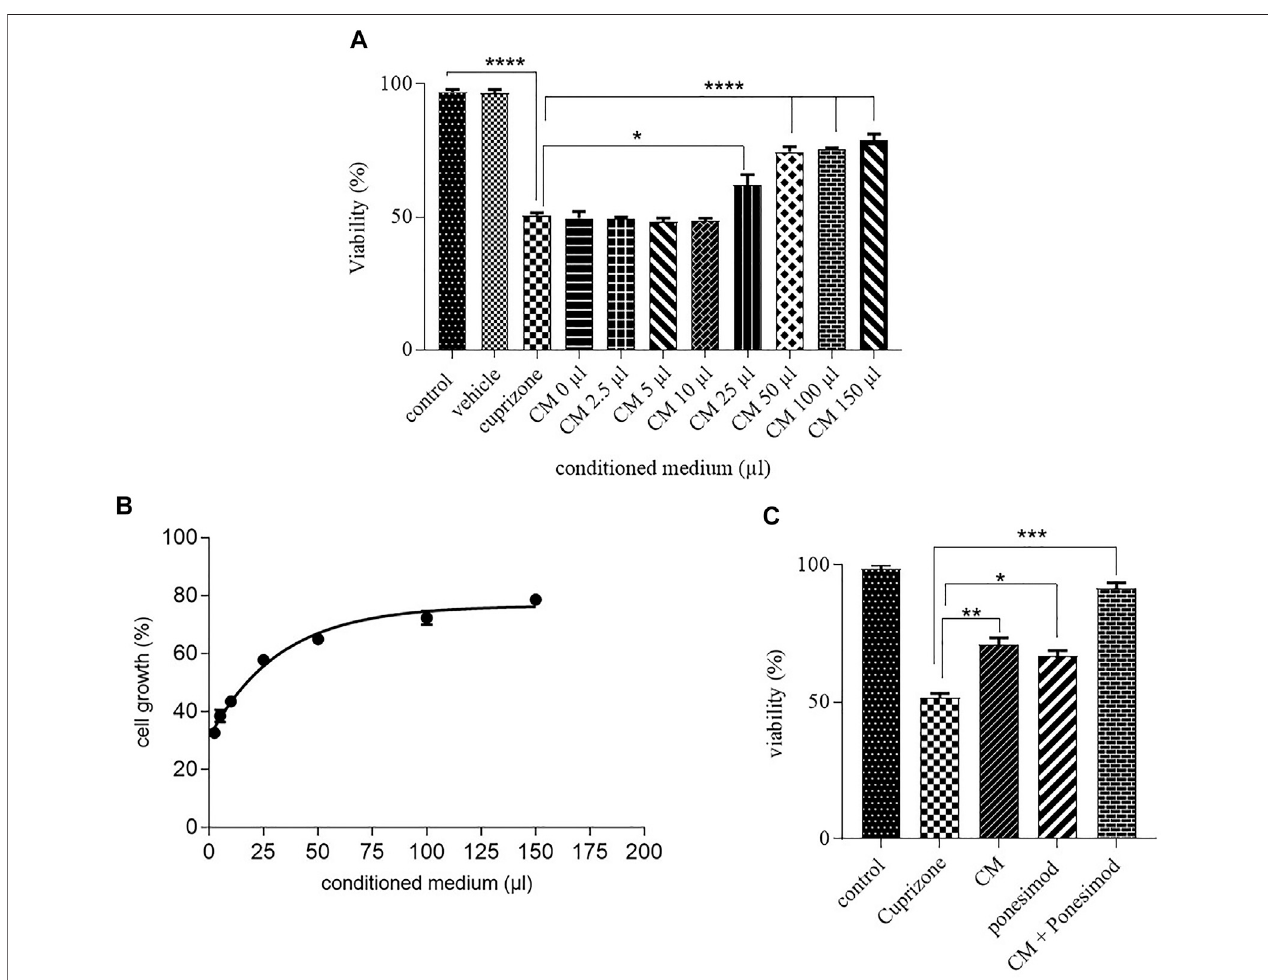
FIGURE3|(A) Inhibition ofoligodendrocyte celldeathbyhAECs-CM after 24 h (* p < 0.05, **** p < 0.0001). (B) adiagram thatshows theEC 50 ofAECs-CM for cell viability in the Oligodendrocyte cell line after exposure with cuprizone for 24 h. (C) Investigation of CM and ponesimod (at concentration of EC 50 (5.7 nM)) on oligodendrocytes survival (* p < 0.05, ** p < 0.01, *** p <